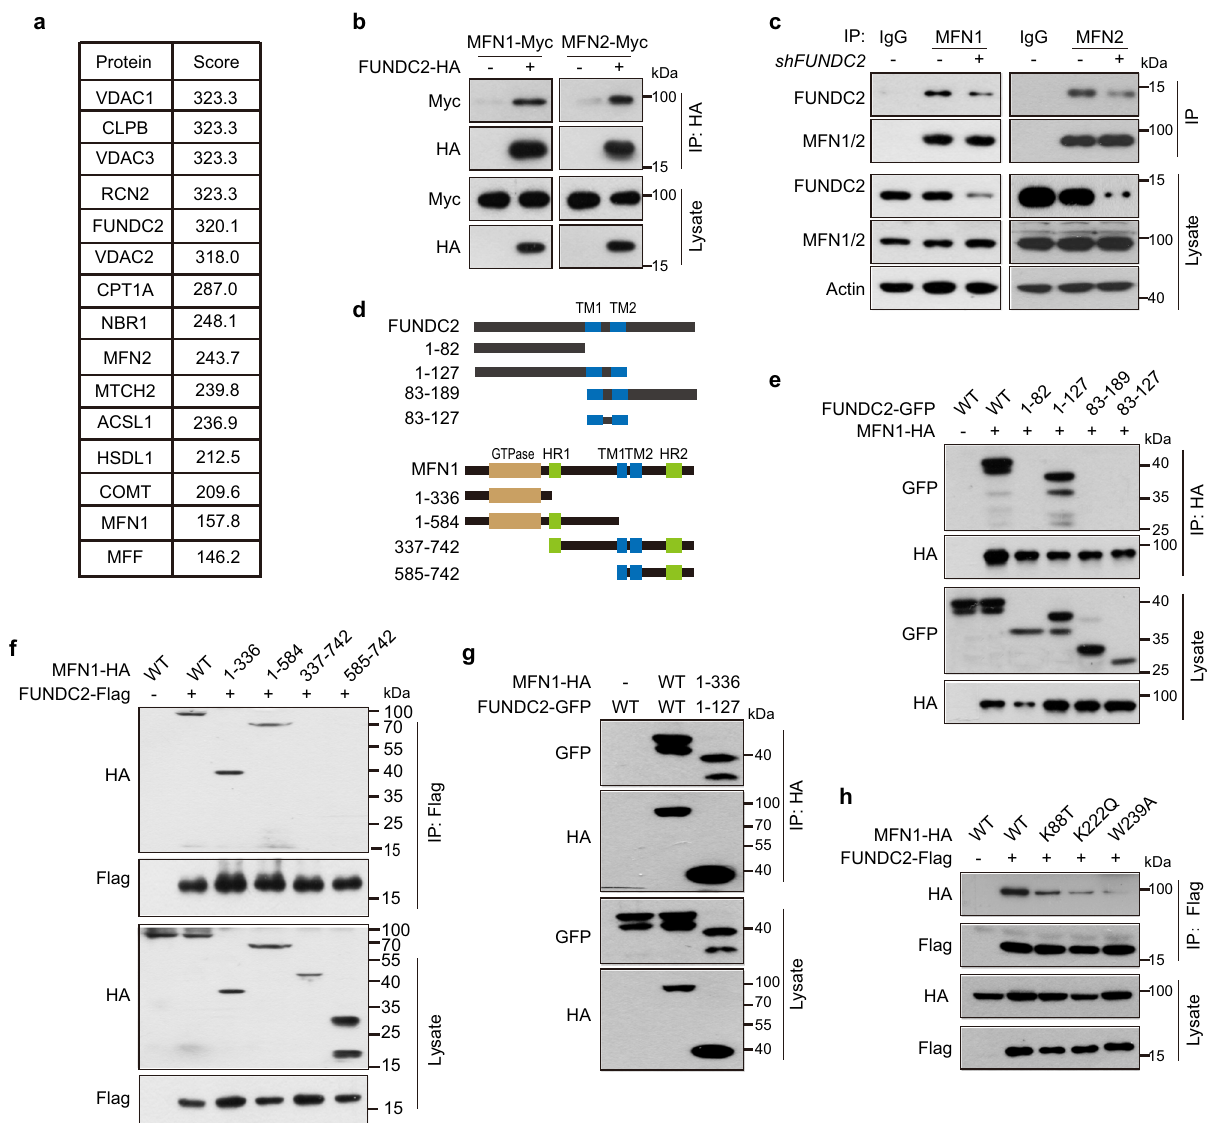
Fig. 4 FUNDC2 interacts with MFN1. a Identi fi cation of FUNDC2-interacting proteins by tandem af fi nity puri fi cation. FUNDC2-Flag-SBP was expressed in Huh-7 cells, co-puri fi ed proteins were identi fi ed by MS. Top hits were shown. b Con fi rmation of FUNDC2-MFN1/2 interaction by co-immunoprecipitation. HEK293T cells were transfected, and immunoprecipitation was done using anti-HA antibody. c Interaction between endogenous FUNDC2 and MFN1/2 in Huh-7 cells. d Illustration of FUNDC2 and MFN1 domain organization and respective mutants. Numbers indicate the position of residues. e Interaction between FUNDC2 mutants and MFN1 in HEK293T cells. f Interaction between FUNDC2 and MFN1 mutants in HEK293T cells. g Interaction between FUNDC2 1 – 127 and MFN1 1 – 336 in HEK293T cells. h Mutation of the GTPase domain impairs MFN1 interaction with FUNDC2 in HEK293T